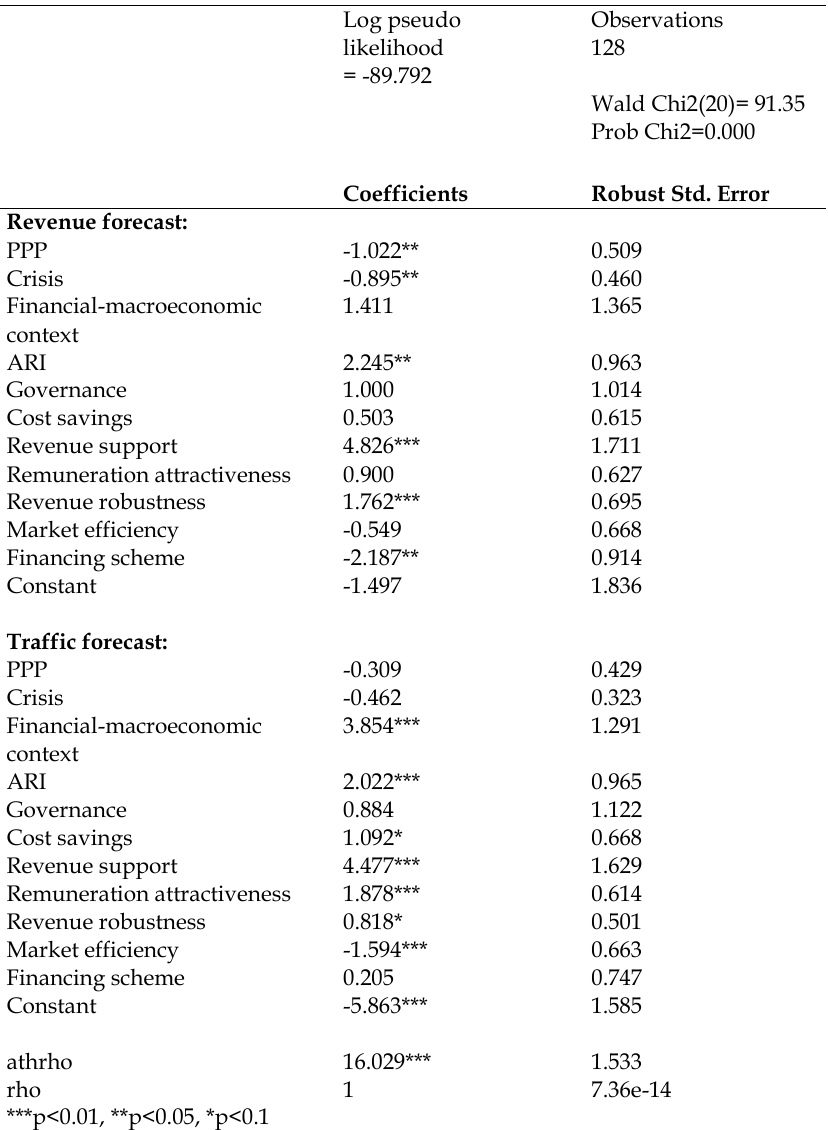
Revenue and traffic estimation (bivariate